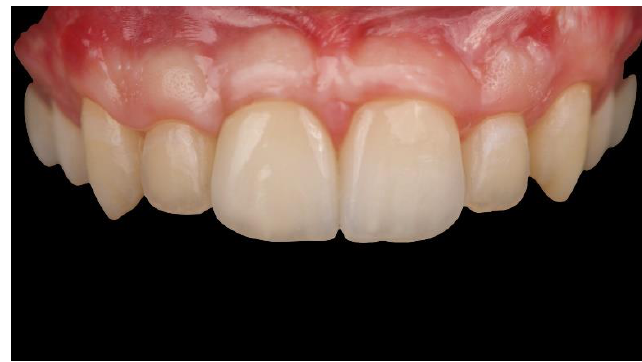
Figure 14. Transition zone showing good soft-tissue healing.